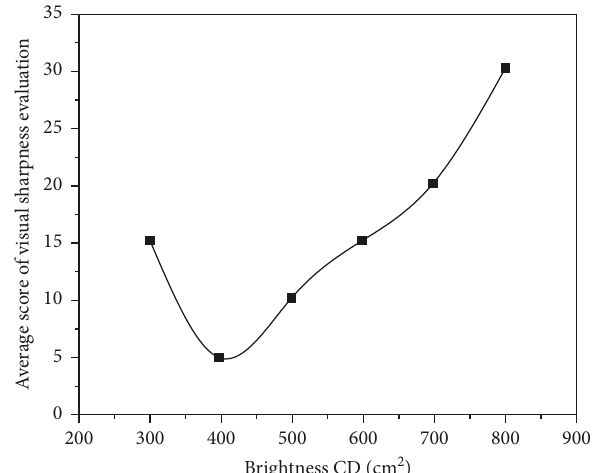
Figure 3: The numerical distribution diagram of the brightness comparison.